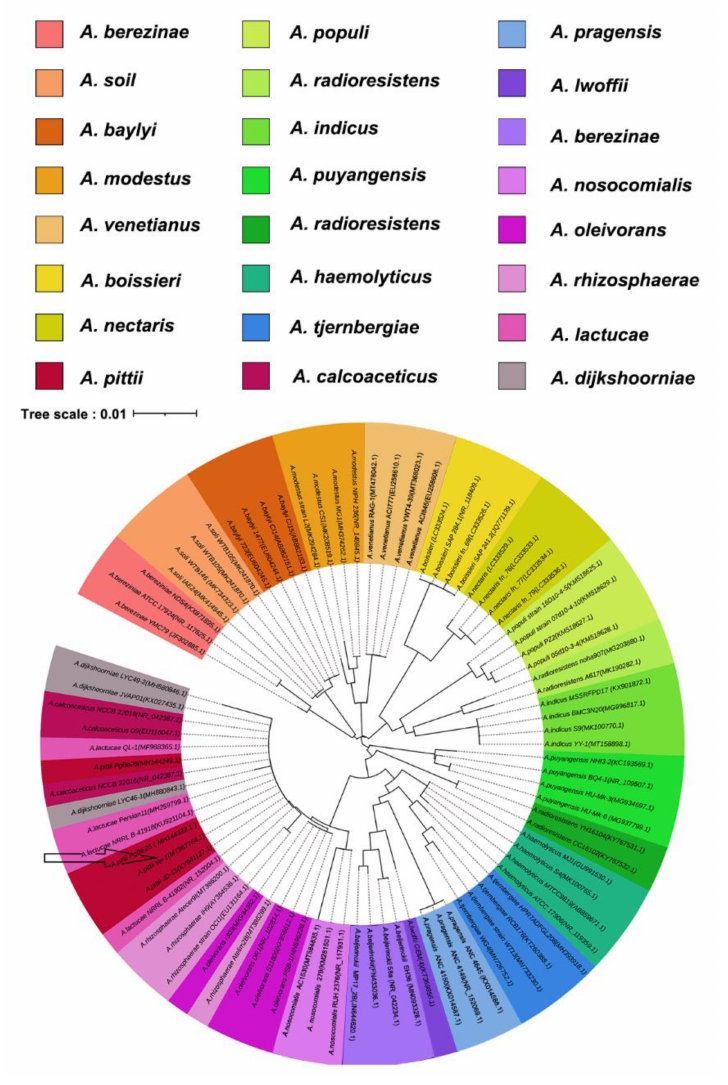
Figure 1. Phylogenetic tree analysis of Acinetobacter strains based on 16S rRNA gene sequencing. The gene sequence of strain sw-1 was compared with that of 23 Acinetobacter isolates to determine its evolutionary position. Data for all 16S rRNA genes were downloaded from NCBI. Phylogenetic and molecular evolutionary analysis was conducted at 1000 bootstrap value using the MEGA software and was visualized by using